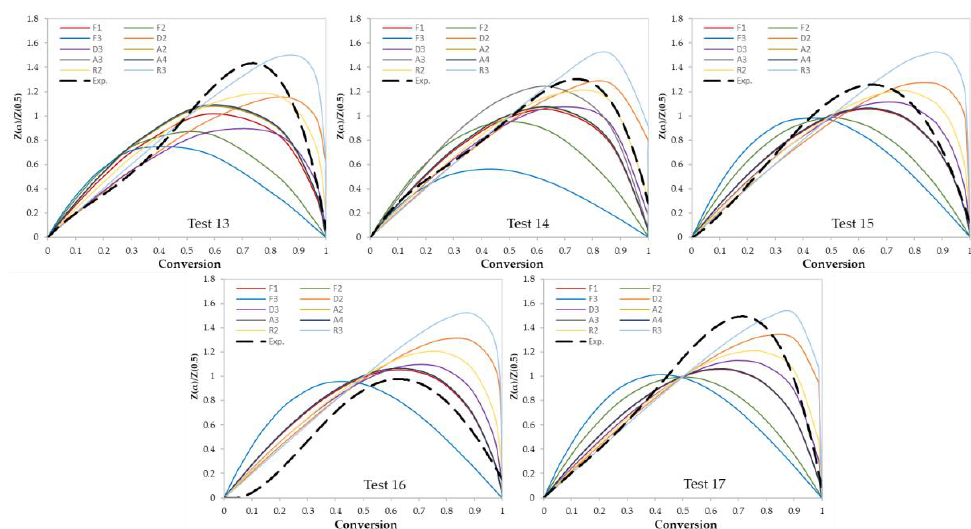
Figure 7. Criado model master plots of ternary and quaternary polymer mixtures. Table 6 . Kinetic parameters of the pyrolysis of mixed polymers obtained by the Coats–Redfern model . Test No.